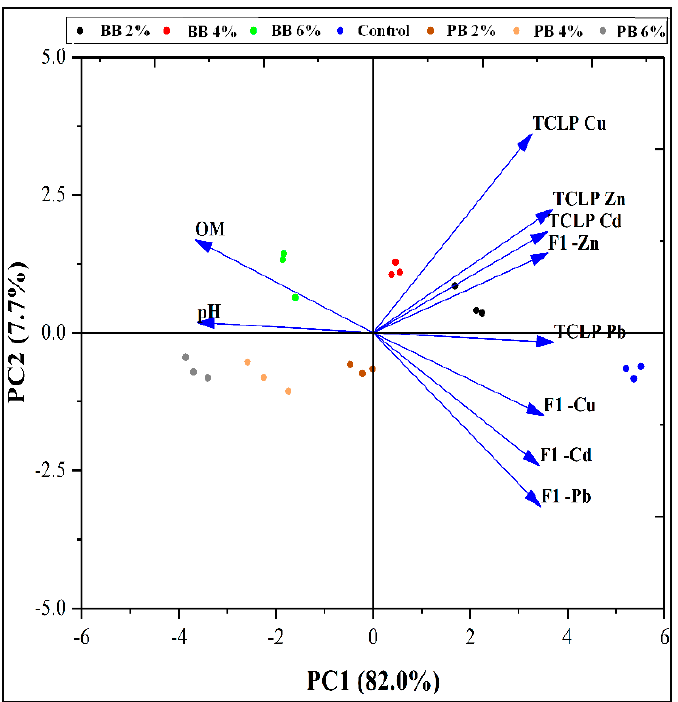
Figure 4. Principal component analysis of TCLP-extractable and acid soluble extractable metals in contaminated soil treated with paulownia biochar and bamboo biochar at the rate of (0-control, 2, 4, and 6%). PC: Principal Components.